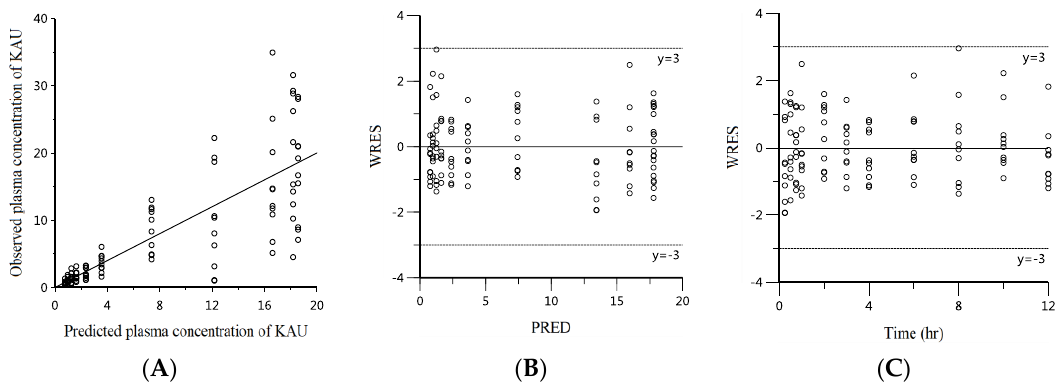
Figure 5. Diagnostic plots for KAU. ( A ) Observations plotted against model predicted plasma concentration. Weighted residuals against model predictions ( B ) or time ( C ).